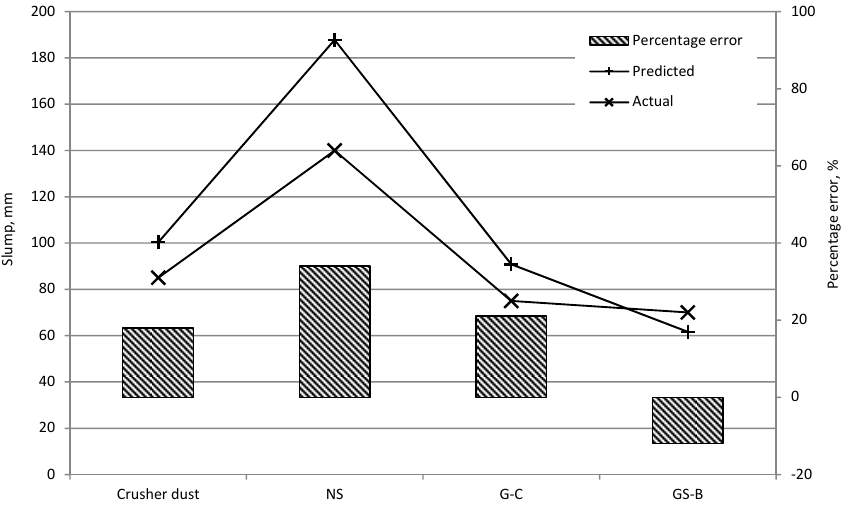
Figure 10. Predicted and actual slump values for validation mixtures.